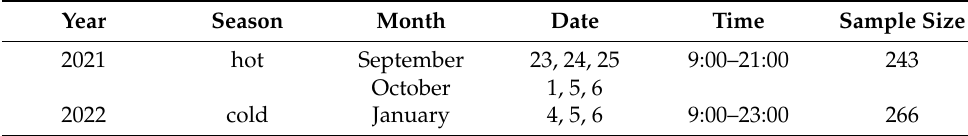
Table 3. Date and time of data